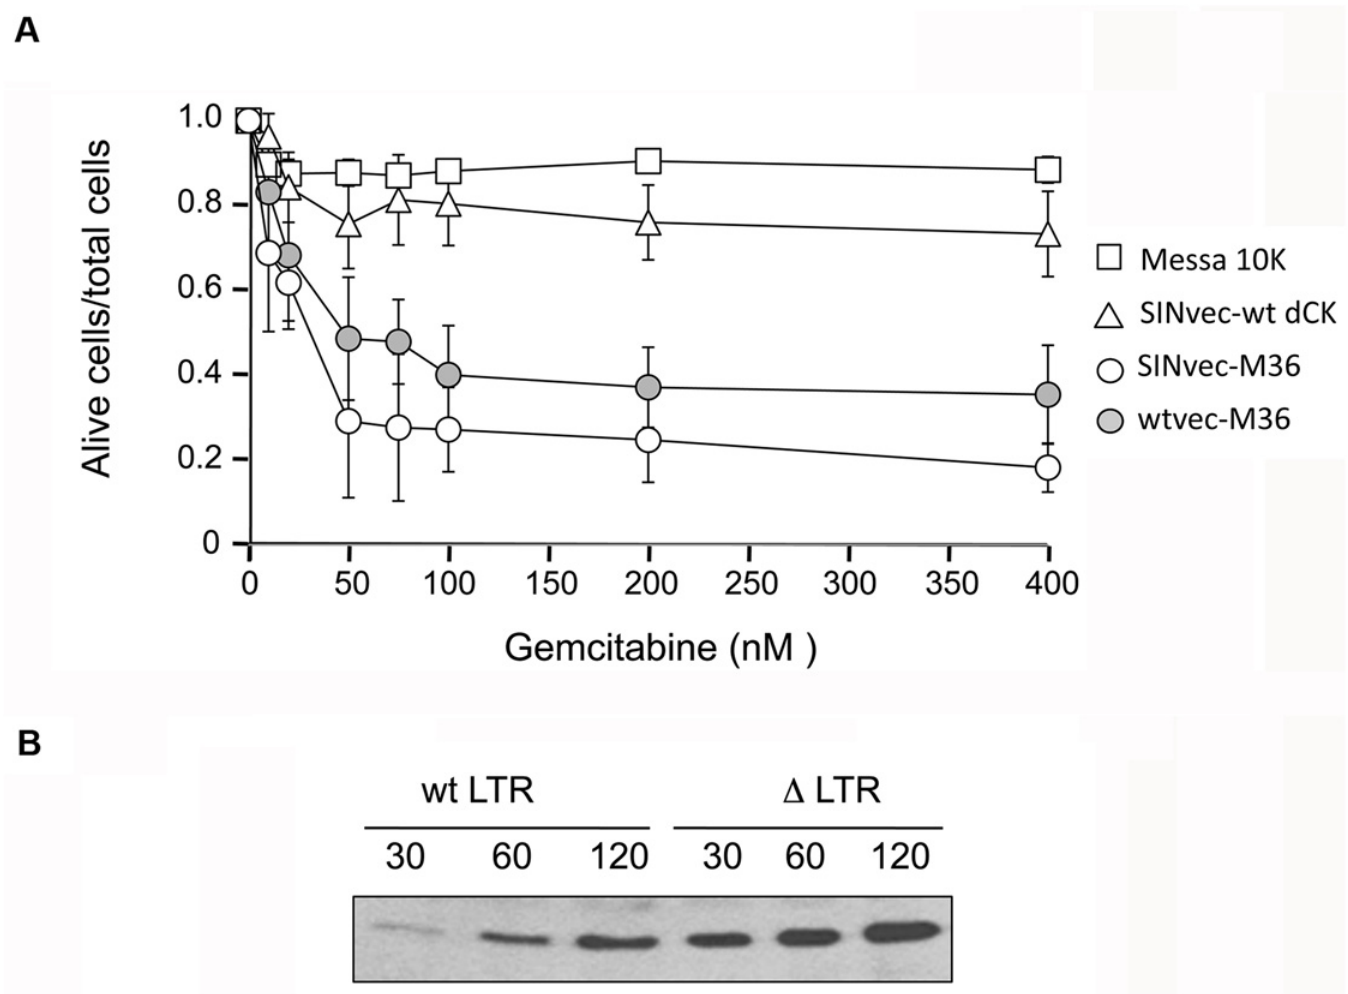
Fig 5. Use of a self-inactivating (SIN) LTR sequence. Panel A, sensitivity of cells harbouring a proviral DNA carrying SIN LTR and expressing M36 (white circles); of cells harbouring a proviral DNA carrying wt LTR and expressing M36 (grey circles, the data for this curve are reported as reference from Fig 4A, where they appear as white diamonds); of cells harbouring a proviral DNA carrying SIN LTR and expressing the wt dCK (white triangles); of wt Messa 10K cells (white squares). The proportion of living cells over the total number of cells is plotted as a function of the concentration of gemcitabine. The averages of three independent experiments are presented. Panel B, Western blot analysis of the expression of wt dCK and of M36 in wt-LTR and in SIN-LTR vectors. The band corresponding to the human dCK is shown for protein extracts from a population of Messa 10K cells expressing the M36 variant from a proviral DNA containing either a wt LTR or a SIN LTR. Three different amounts of total protein extract were loaded for each sample, as indicated (in μ g) above each lane. The picture shows a representative result of 3 independent Western blot